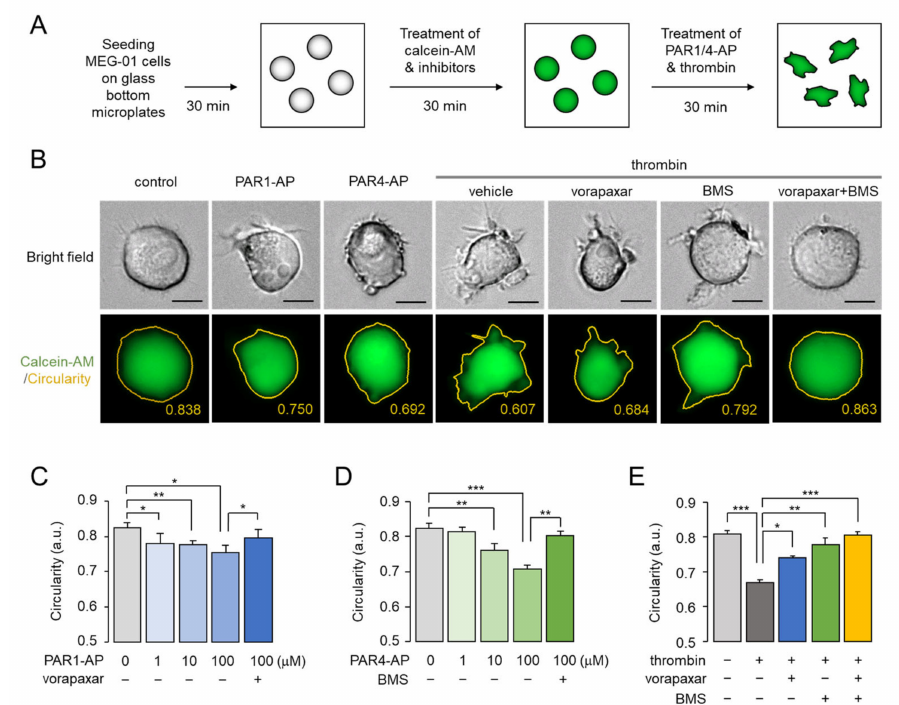
Figure 4. PAR1- and PAR4-mediated morphological changes in living MEG-01 cells. ( A ) Schematic diagram of experimental setup. ( B ) Representative images of MEG-01 cells used for analysis of circularity measurements. Cells were stained with calcein-AM (1 µ g/mL) and pretreated with 10 µ M of vorapaxar and BMS-986120 (BMS), and then PAR1-AP (100 µ M), PAR4-AP (100 µ M), or thrombin (0.1 U/mL) were applied for 30 min. Scale bar = 10 µ m. ( C – E ) Summary of circularity. PAR1 and PAR4 were inhibited with vorapaxar and BMS-986120 (BMS) at the indicated concentrations, respectively. Thrombin-induced activation of PAR1 and PAR4 was blocked by vorapaxar (10 µ M), BMS-986120 (10 µ M), or both, respectively. Images were captured automatically and circularity was measured using Lionheart software (mean ± S.D., n = 4–5). * p < 0.05, ** p < 0.01, *** p <